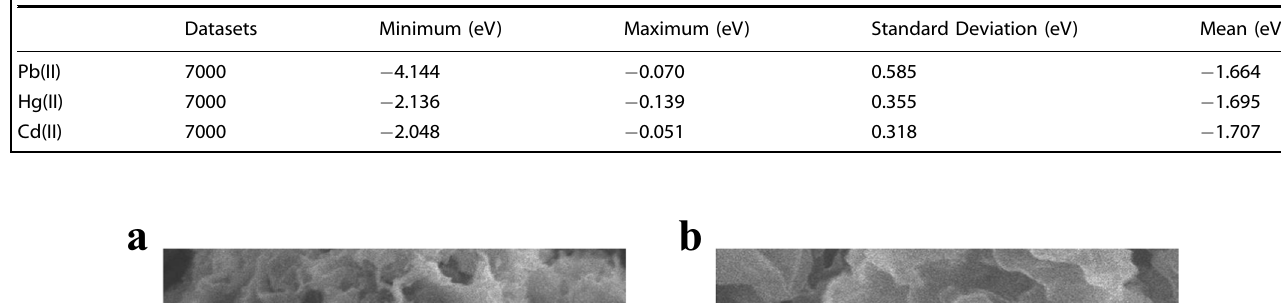
θ = 13.2° and 27.6° are observed, 3 N 4 . Two strong peaks at 2 which are indexed to the (100) and (002) planes of graphitic nature, respectively 40,41 .